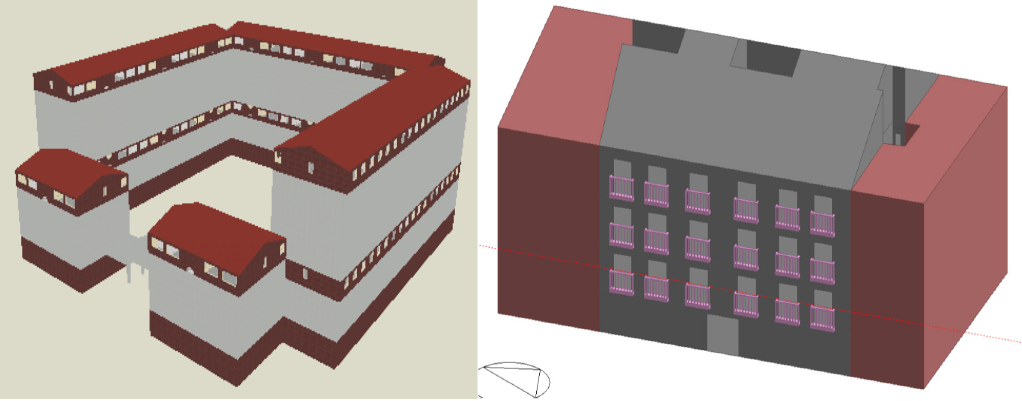
Figure 4. 3D model of: building A ( left ); and building B ( right ).